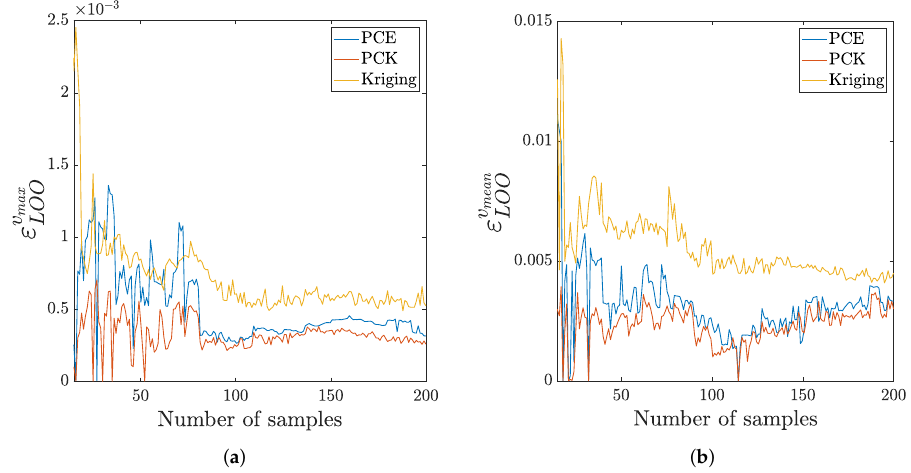
Figure 6. Convergence of LOO error estimates of ( a ) v max and ( b ) v mean surrogates.